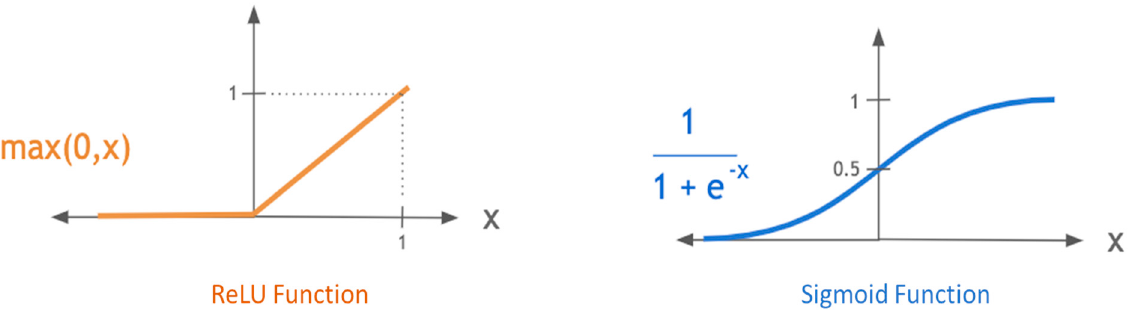
Figure 7. The common activation functions for neural networks [46–48]. The ReLU function compares zero with the inputs and selects the maximum. This means the positive inputs are unaffected, while any negative input becomes zero. The ReLU function is valuable where negative values do not make much sense or for eliminating linearity without heavy computation.